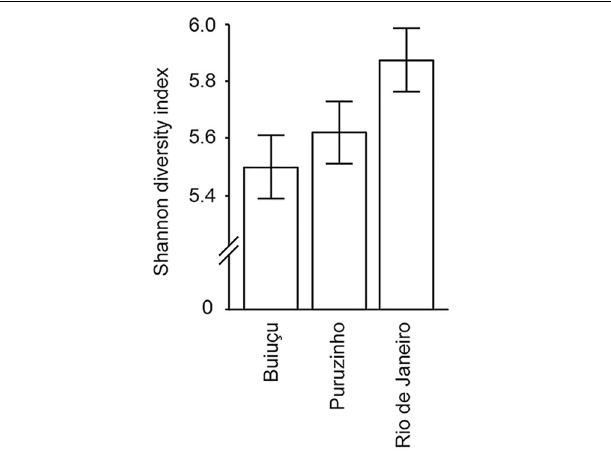
FIGURE 1 | Alpha diversity of the gut microbiome of individuals from the three communities studied. Diversity values and standards deviation are shown, as determined by Shannon index analyses of rarified